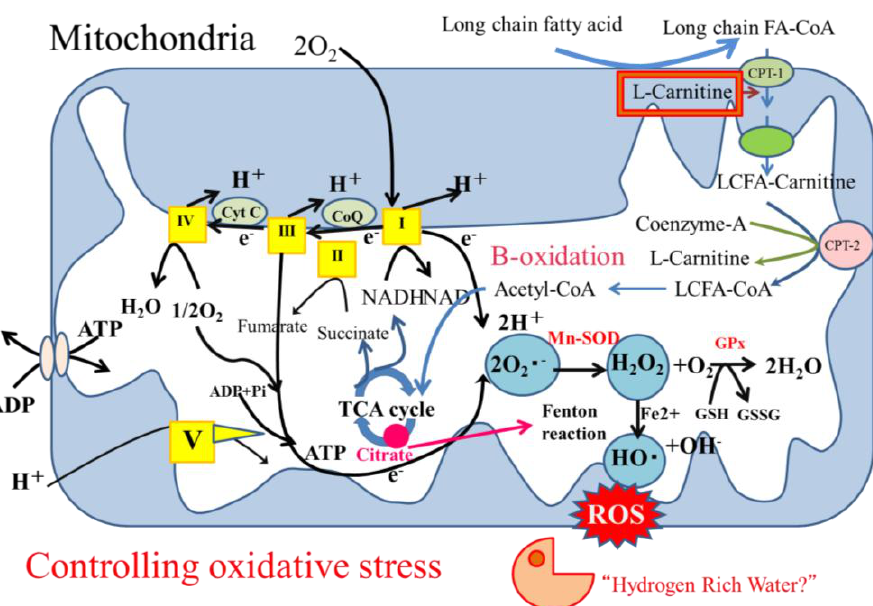
Figure 2. Mitochondria as producers of oxidative stress. High levels of plasma free fatty acids allow upregulation of hepatic free fatty acids. Long-chain fatty acids taken up into mitochondria as complexes with L -carnitine are then transferred to β-oxidation pathway. Under oxidative stress, oxidative reactions convert oxidized cofactors (NAD+ and FAD) into reduced cofactors (NADH and FADH2) and deliver electrons to respiratory chain. Imbalance between increased delivery of electrons to respiratory chain and their decreased outflow from this chain causes electrons and ROS products to accumulate. Anti-oxidant defenses such as superoxide dismutase (SOD), glutathione peroxidase (GPx) or catalase can metabolize hydrogen peroxide to non-toxic H O. However, the Fenton and/or 2 Haber-Weiss reactions generate highly reactive toxic ROS, hydrogen peroxide. Hydrogen as selective cytotoxic ROS scavenger and L -carnitine as mitochondrial function supporting factor might be good candidates for controlling mitochondrial oxidative